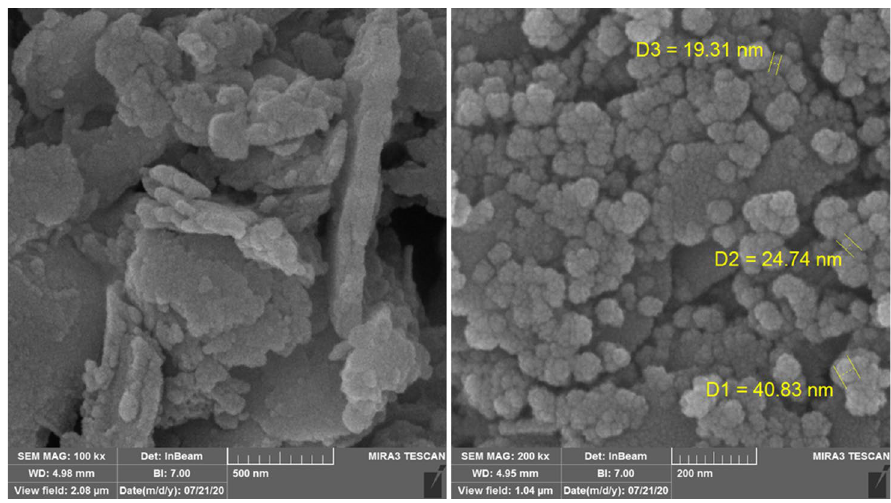
Figure 5. SEM image of Fe 3 O 4 -g-C 3 N 4 -Alg-Ag nanomaterials.